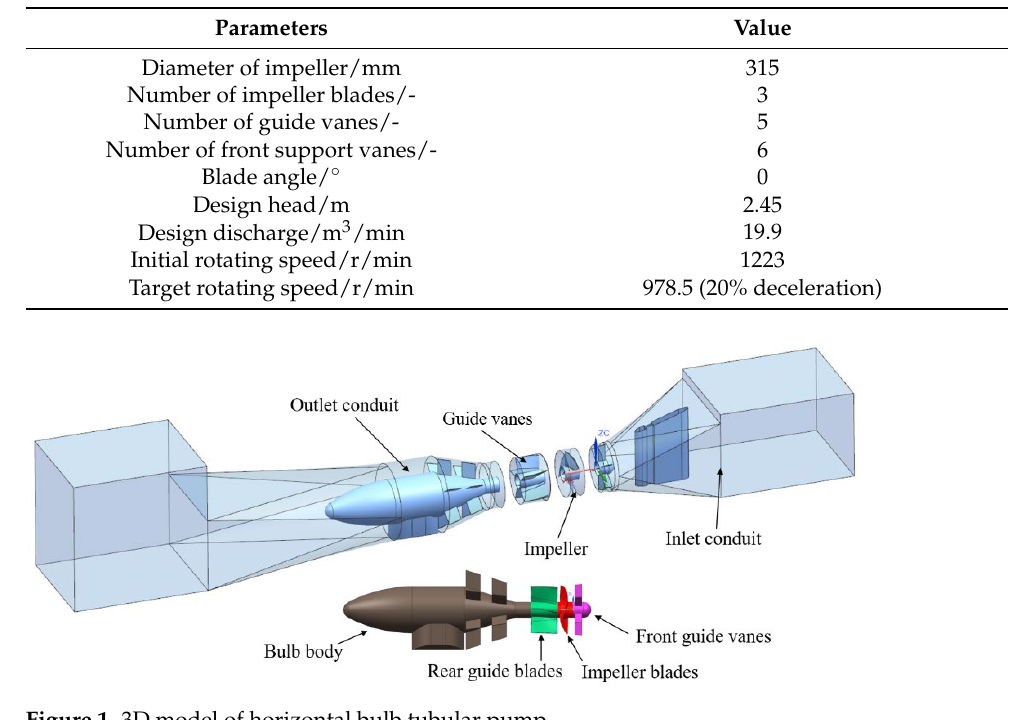
Figure 1. 3D model of horizontal bulb tubular pump.